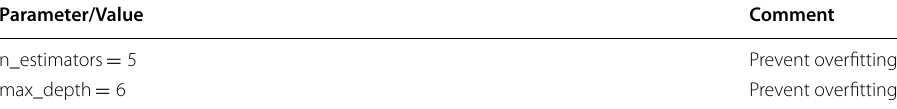
Table 15 Supervised ranking classifier Random Forest initialization options Parameter/Value